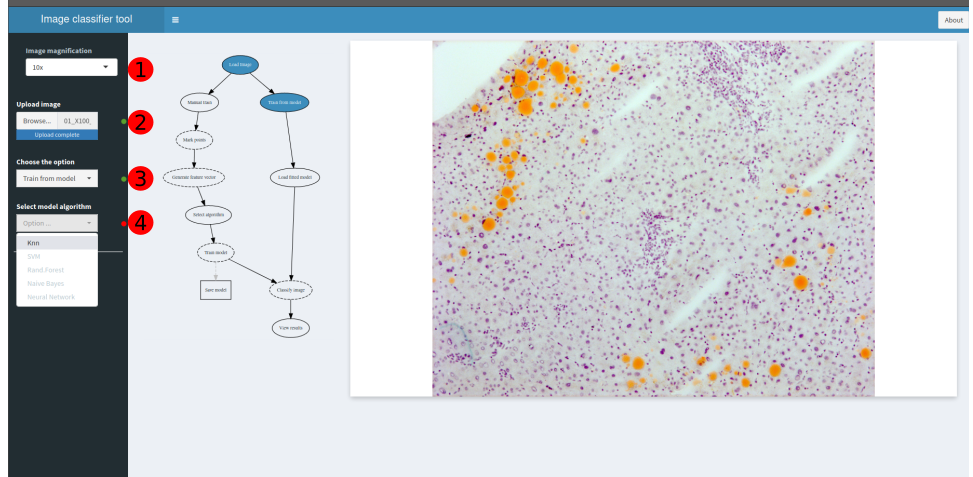
Figure 6. Web application interface image classification steps: (1) Objective magnification selector; (2) Image uploader; (3) Manual or pre-trained model selector; and (4) (if pre-trained) algorithm